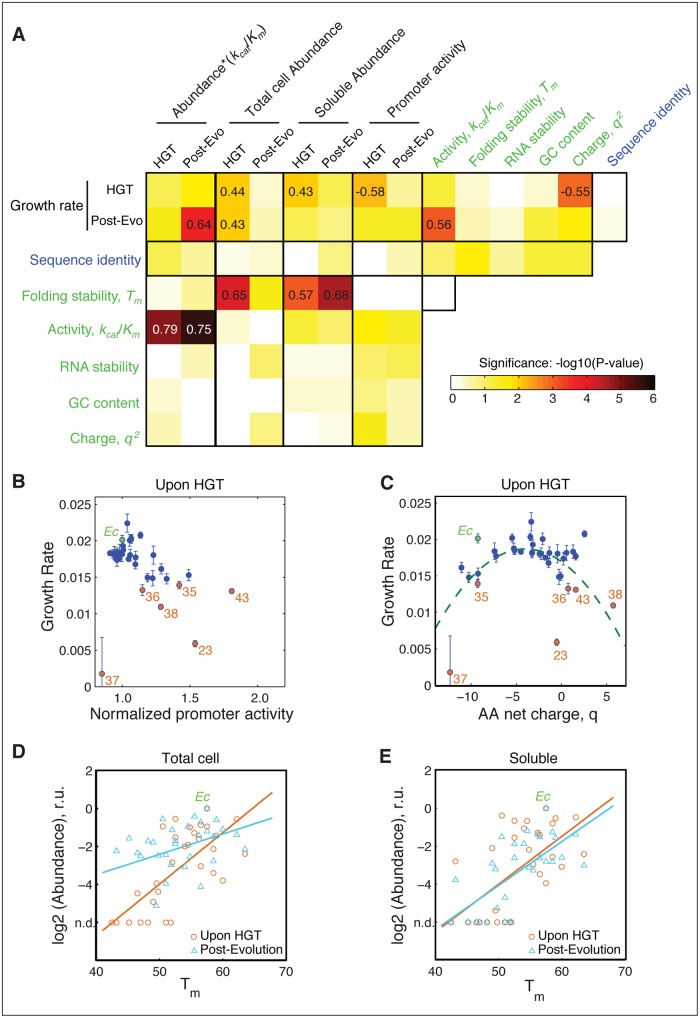
The role of molecular and cellular properties in the fitness effects of HGT.A) Correlation between growth rates, sequence and biophysical properties, and cellular responses (S1, S2 and S3 Tables) Blocks are colored according to −log10 (p-values) of Spearman correlation. Correlation coefficients with p-values<10−2 are indicated within the blocks. Promoter activity of the DHFR genes (endogenous folA promoter) is measured as a ratio between GFP signal from pUA66 plasmid and optical density of the growing cultures (see Materials and Methods). RNA stability is calculated over a 42 nt window starting near the translation site (-4) (see Materials and Methods and). Both RNA folding stability and GC content are calculated using the adapted DNA sequences (S2 Table). Neither GC content nor RNA folding stability correlates with fitness. Besides having a good correlation with kcat/KM and abundance*kcat/KM (Fig 3), fitness before evolution experiment shows significant correlation with promoter activity and net charge of DHFR. B) Activation of folA promoter is inversely correlated with growth rate before evolution, a signature of deficiency in intracellular DHFR abundance. This correlation disappears after the evolution experiment (S4A Fig), indicating an increase in DHFR abundance. C) Growth rates before evolution experiment exhibit an apparent quadratic dependence on the net charge q of the DHFR amino acid sequence. Dashed curve is the regression through the points defined by (q+3.5)2 (p-value <10−4). The dependency becomes much less pronounced after the experimental evolution (S4B Fig). D,E) Intracellular DHFR abundance measured in total cell lysate (D) and soluble fraction (E) immediately before evolution correlates with folding stability T
m (orange circles) (r = 0.65; p-value <104 for total cell, and r = 0.57; <103 for soluble). After the evolution, a strong increase in DHFR abundance as measured in total cell lysates weakens the correlation with Tm (blue triangles; r = 0.41, p-value = 0.025) (D), but the strong correlation with Tm is preserved for soluble abundances (blue triangles; r = 0.68, p-value<104) (E).